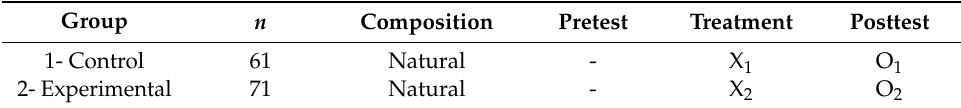
Table 1. Composition of the